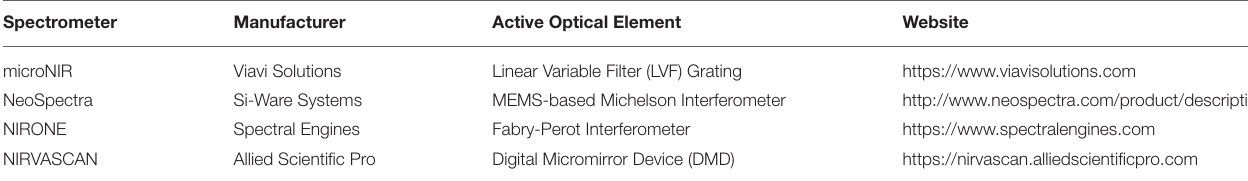
TABLE 3 | Ultra-portable NIR